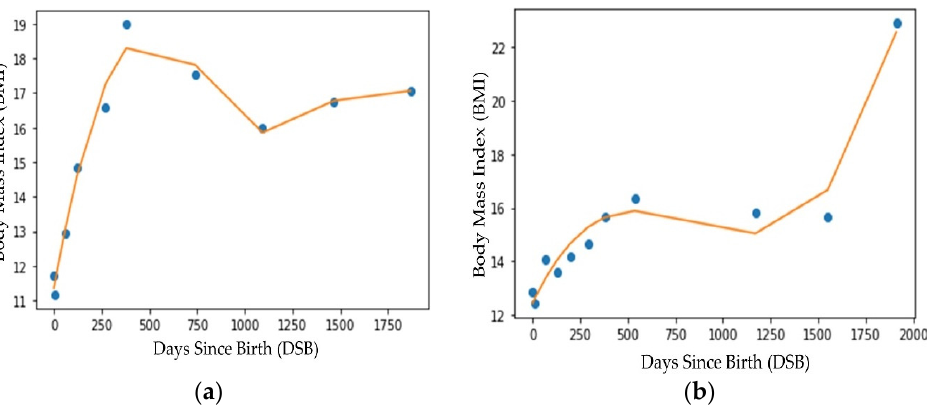
Figure 3. Regression line fitting (3rd degree polynomial) for two different subjects ( a ) child 1 and ( b ) child 2.